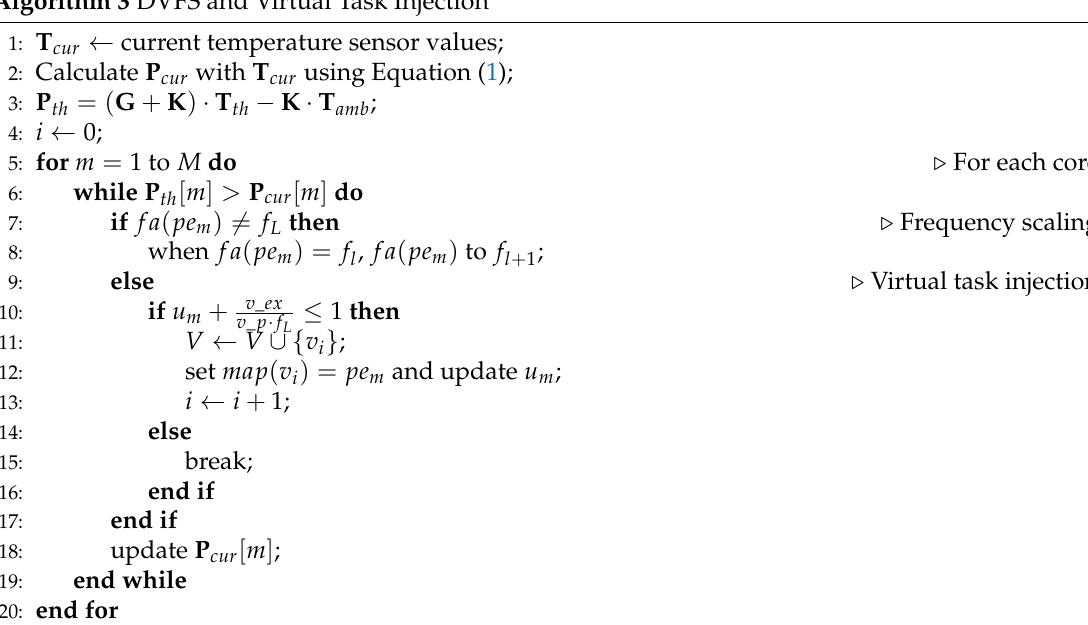
Algorithm 3 DVFS and Virtual Task